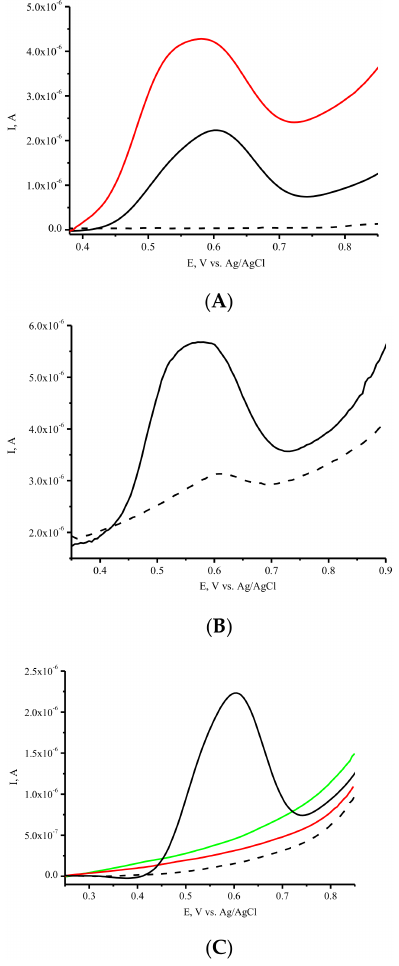
Figure 3. ( A ). DPV electrochemical oxidation signals of SPE/SWCNT/ASNase, 3 µ g/ µ L (-), and 5 µ g/ µ L (-), SPE/SWCNT (—). ( B ). DPVs of the first (-) and the second (—) scan of SPE/SWCNT/ASNase (5 µ g/ µ L). ( C ) DPVs of SPE/SWCNT/ASNase, 3 µ g/ µ L (-), 33 mM L-Asn (-), and 33 mM Gly (-) on SPE/SWCNT, SPE/SWCNT (—). Supporting electrolyte: 0.1 M potassium- phosphate buffer containing 0.05 M NaCl, pH